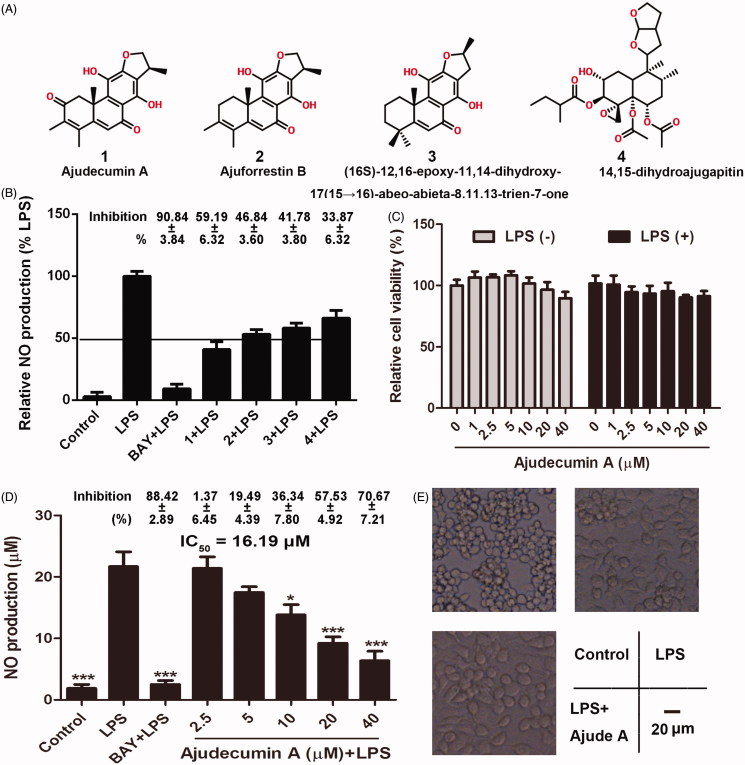
Ajudecumin A inhibited NO production and morphological changes in LPS-activated RAW264.7 macrophages. (A) Chemical structure of Ajudecumin A (1), Ajuforrestin B (2), 14,15-dihydroajugapitin (3), and (16S)-12,16-epoxy-11,14- dihydroxy-17(1 5 →16)-abeo-abieta-8,11,13-trien-7-one (4) from Ajuga ovalifolia var. calantha. (B and D) RAW264.7 cells were pre-treated with the tested compounds at the indicated concentrations and BAY 11-7082 (5 μM) for 2 h, and then incubated with LPS for 24 h. Levels of NO in the culture medium were assessed using Griess reagent. (C) Cells were treated with the tested compounds at the indicated concentrations for 24 h in the presence of LPS (0.5 μg/ml) or not. Cell viability was measured by CCK8 assay and expressed relative to the vehicle control. All data are represented as mean ± SD, n = 6. *p < 0.05, **p < 0.01, ***p < 0.001 vs. LPS alone. The inhibition rates (%, compared with the LPS alone) are also shown. (E) After treatment of Ajudecumin A and LPS, the morphology of RAW264.7 cells was observed under light microscope, bar =20 μm.